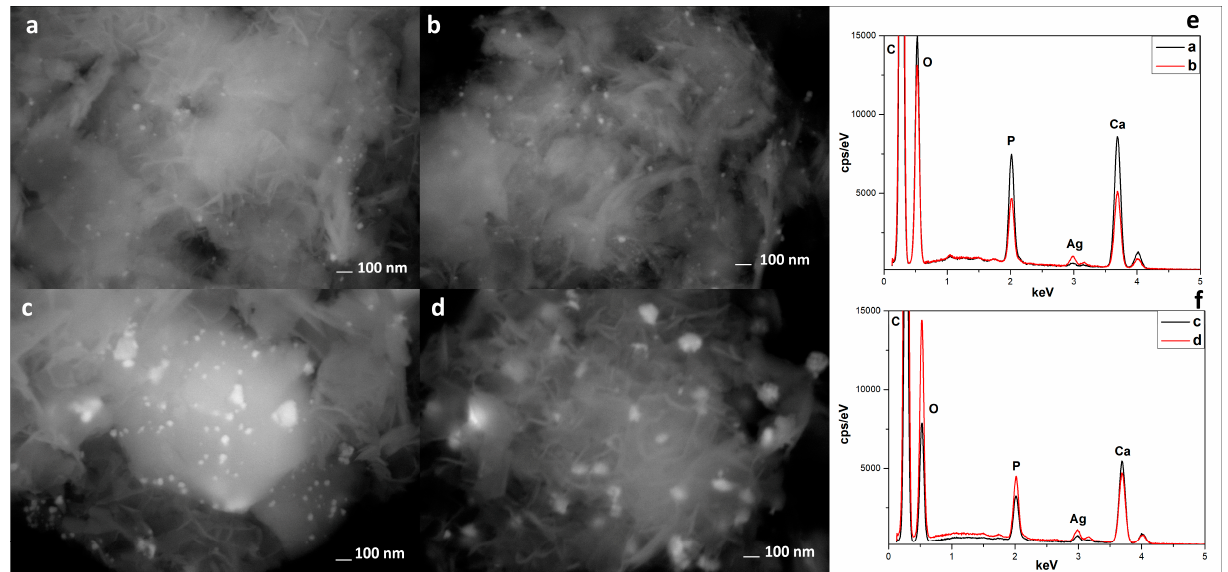
Figure 4. SEM analyses with a back-scattered detector of US50B ( a ), US100B ( b ), US50C ( c ), and US100C ( d ), and EDX spectra of US50B–US100B ( e ) and US50C–US100C ( f ). To better highlight the shape and size, TEM analyses (Figure 5) were performed. The TEM images showed the good distribution on the OMP surface and the spherical shape of the silver-based nanoparticles; moreover, the average size is in agreement with that found by the Scherrer equation.